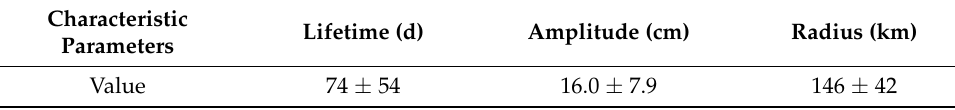
Table 4. Characteristics of the shelf ‐ internal ‐ generation mesoscale eddies.